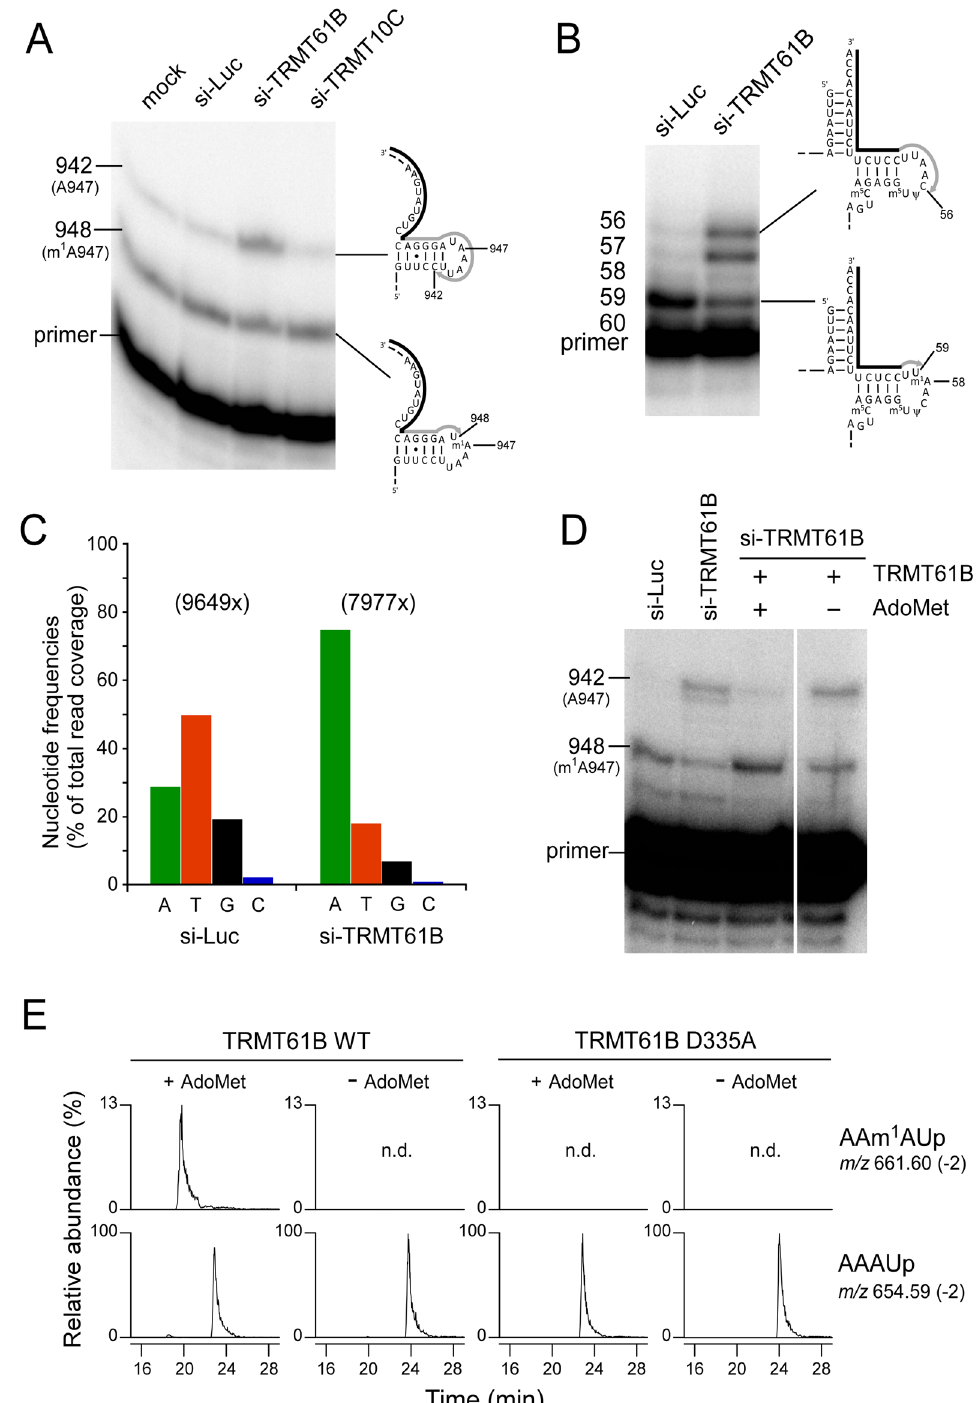
Fig 2. TRMT61B is responsible for m 1 A947 in mitochondrial 16S rRNA. (A) Detection of hypomodified m 1 A947 in mitochondrial 16S rRNA from siRNA-treated HeLa cells. After knockdown of luciferase (si-Luc, control), TRMT61B, or TRMT10C mRNAs, primer extension was used to detect methylated or non-methylated A947. The cells were transfected twice with siRNA and harvested 4 days after the first transfection. The knockdown efficiencies of TRMT61B and TRMT10C mRNAs were quantified by qRT-PCR and normalized to ACTB mRNA. The steady-state levels of both mRNAs were decreased to 5.7% compared to the mock